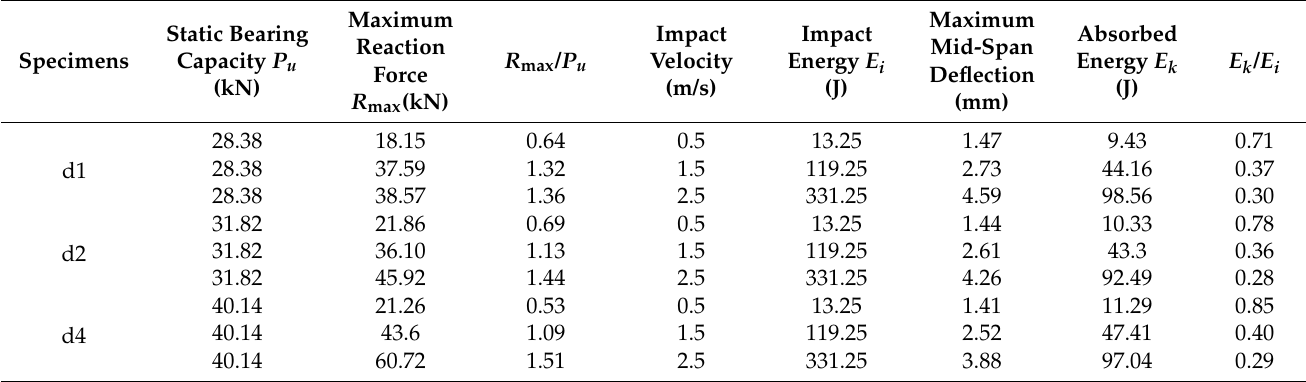
Table 4. The numerical results of notched beams with different setups of steel